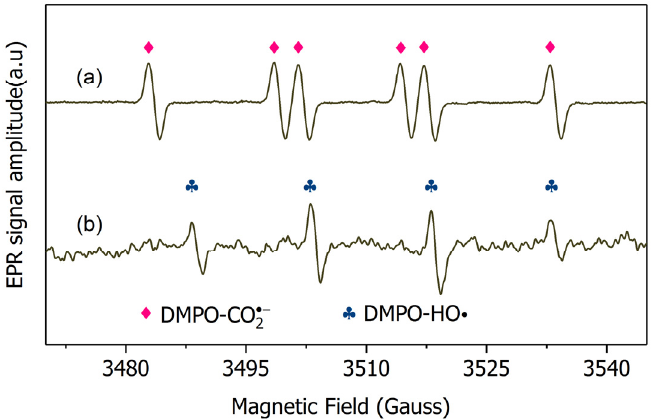
Figure 7. EPR spectra obtained from ( a ) UV/BiOCl-HAP SM /Formate and ( b ) UV/BiOCl-HAP SM systems in the presence of DMPO. Conditions: BiOCl-HAP SM dose 0.5 g · L − 1 , [DMPO] 0 = 10 mM, [BrO − ] 0 = 6.6 µ M, [Formate] 0 = 4.0, pH = 7.0, 25 °C.